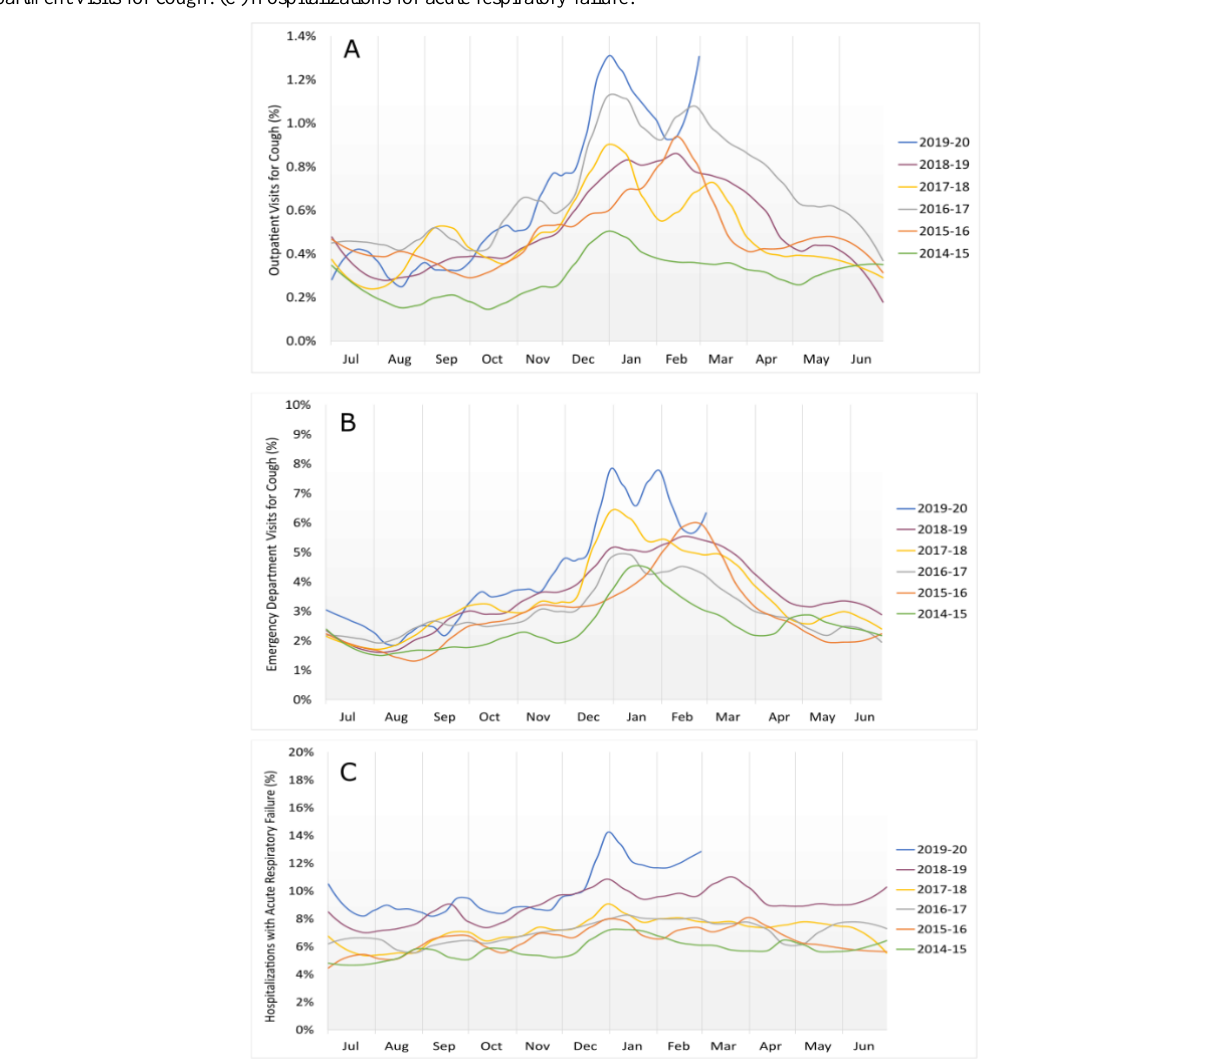
Figure 1. Percentage of outpatient and emergency department visits for cough and hospitalizations for acute respiratory failure from July 1, 2014, to February 29, 2020. Vertical reference lines align to the first day of each month. (A) Outpatient clinic visits for complaints of cough. (B) Emergency department visits for cough. (C) Hospitalizations for acute respiratory failure.